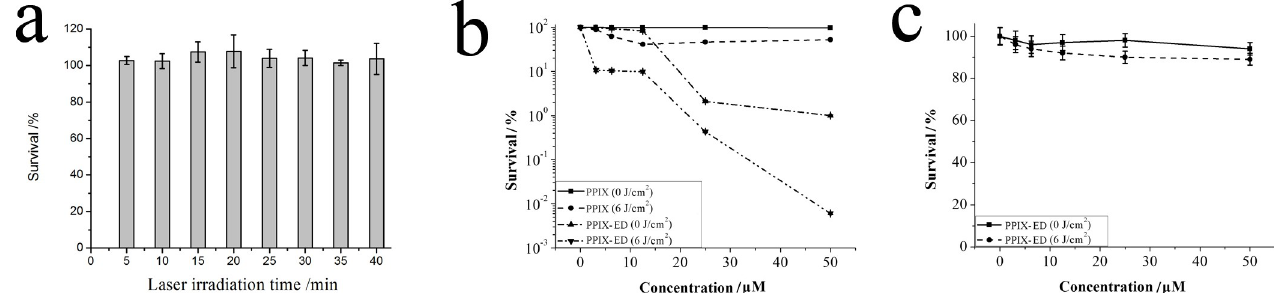
Fig 5. Effects of (a) light alone on Pseudomonas aeruginosa and (b) photoinactivation by protoporphyrin IX–ethylenediamine derivative (PPIX-ED) and PPIX in P . aeruginosa . (c) Photoinactivation of NIH3T3 cells by PPIX-ED. The bacteria and fibroblasts were incubated with the compounds over the concentration range of 3.13–50.0 μ M for 30 min followed by exposure to 650 nm irradiation (6 J/cm 2 ) or dark exposure. The results are expressed as the mean and standard